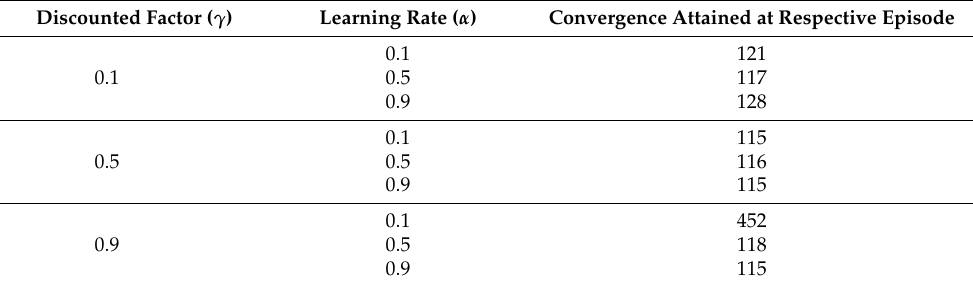
Table 3. Optimal stretch comparison of learning agent.